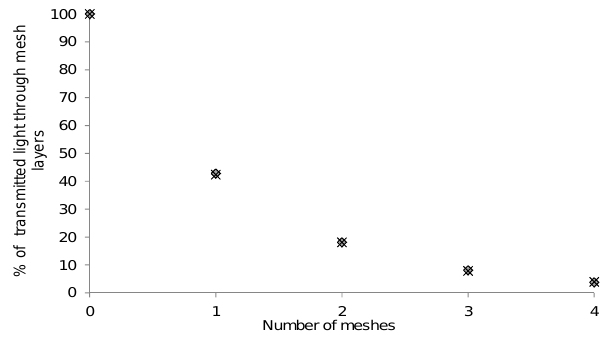
Figure 11. Experimental measurements and theoretical calcula- tions for the percentage of the transmitted UV solar light (300– 400nm) through coated woven meshes ( r = 0.45) with separation distance 1cm in the presence of different concentrations of